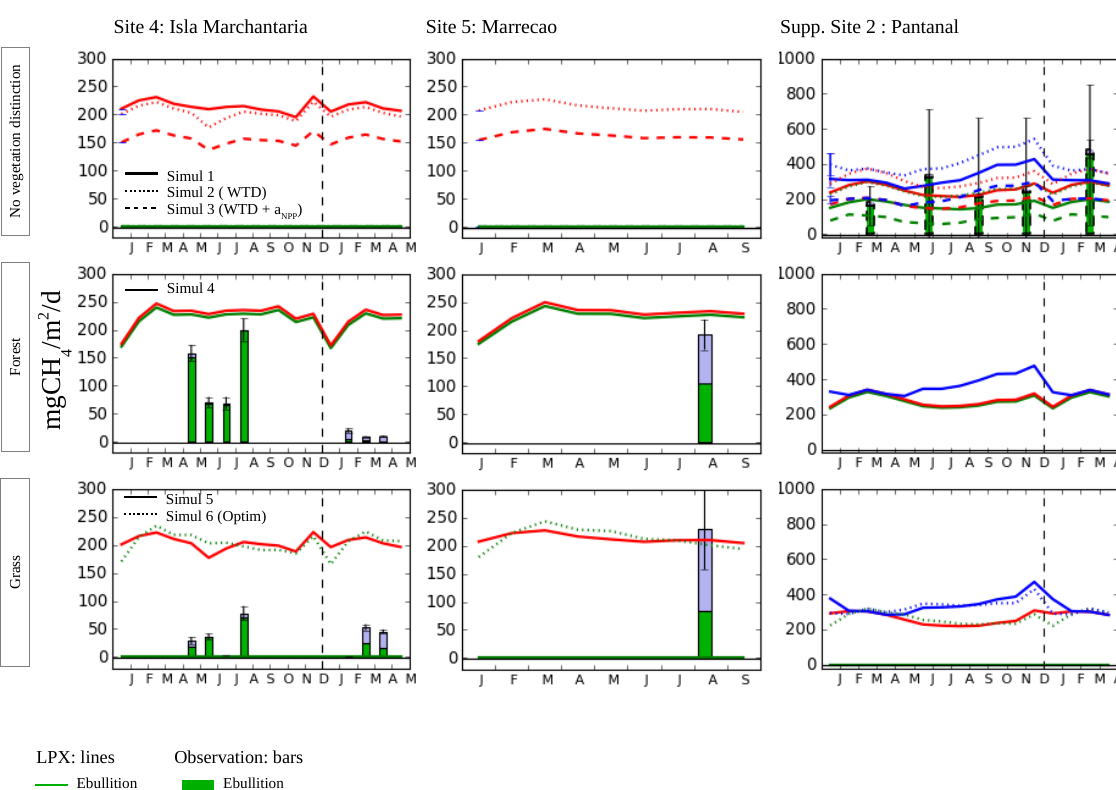
Fig. 6. Comparison of mean annual CH 4 flux densities between LPX simulations and observations at sites 4, 5 and Supp. Site 2. For these sites, monthly information about CH 4 flux density is available. The different columns correspond to the different sites. For each site, three panels are given: without distinction in vegetation (top), for flooded forest (middle) and flooded grassland (bottom). The LPX optimal simulation is added in last